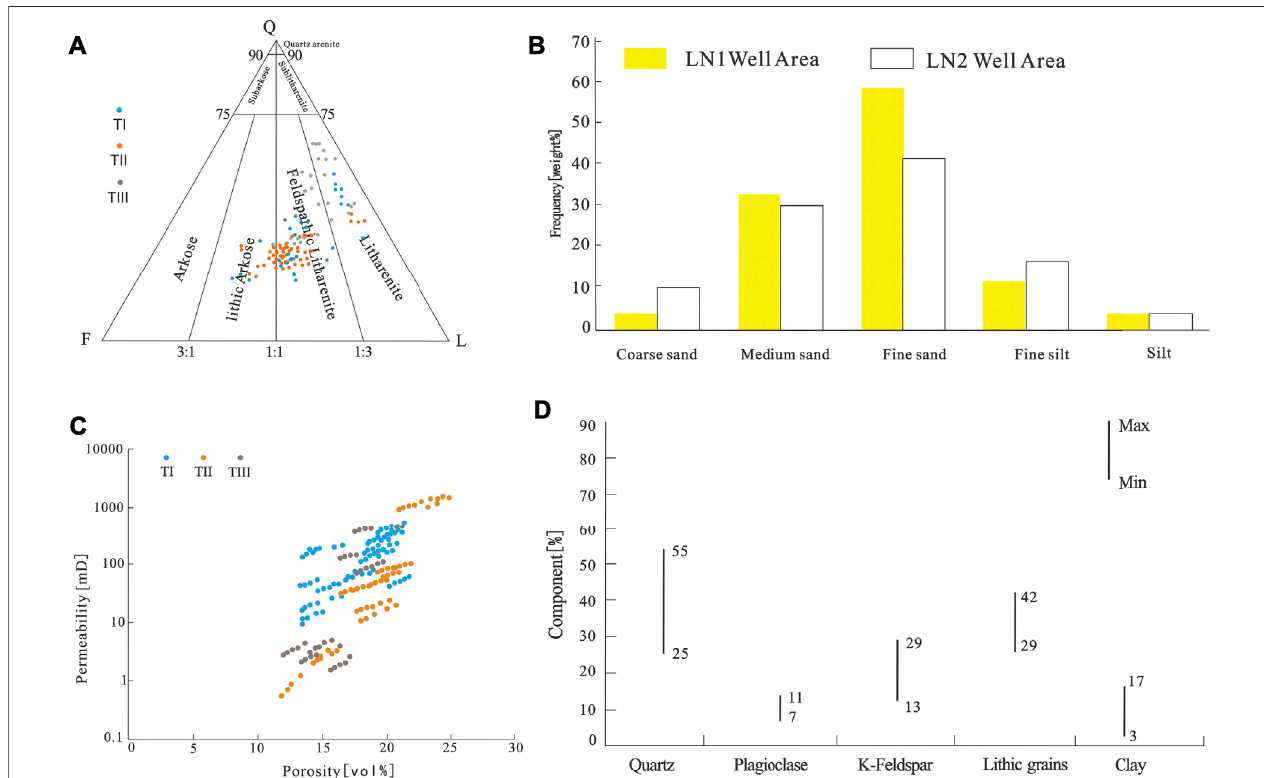
FIGURE 3 | (A) Ternary diagram showing the framework grain composition of the study area sandstones, plotted on the Folk (1968) diagram (Folk and Ward, 1957). F, feldspar; L, lithic grains; Q, quartz. (B) Grain size distributions of sandstones in the Lunnan area. (C) Core-measured porosity versus core permeability cross- plots at 56 mPa (8,145 psi) net con fi ning stress for sandstones in the Lunnan area. (D) X-ray diffraction data of sandstones in the Lunnan area.